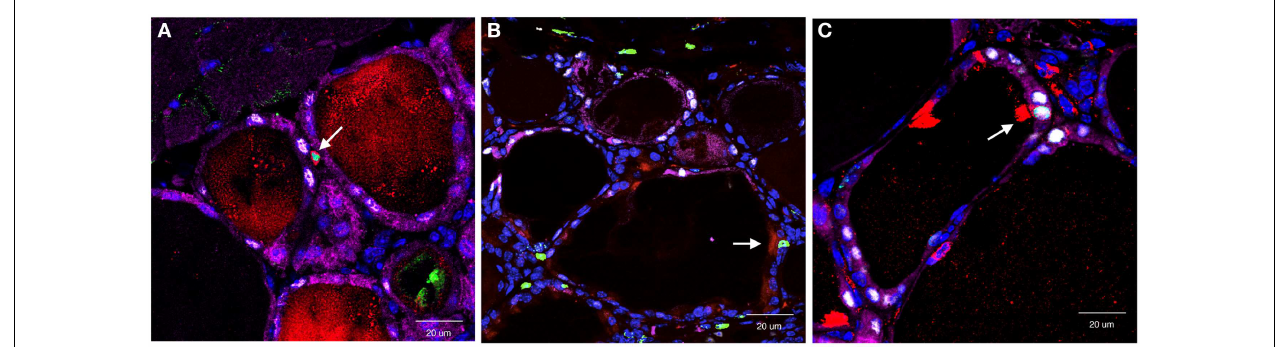
day 35, red/green positive signal was found as an intrafollicular cell, that did not express NKX2-1 (white), nor β -gal (purple). At day 120, intrafollicular cells expressing all four proteins were seen. Double or quadruple positive cell in each panel is shown by an arrow. In (C) , strong SCA1 signal is due to cilia that this SCA1( + ) cell